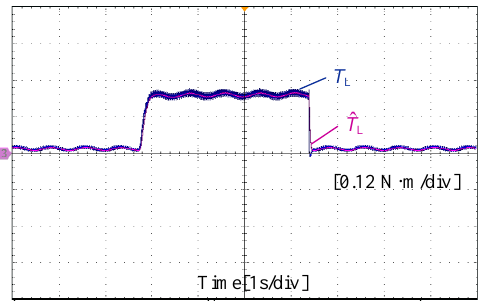
Figure 12. Evaluation of the second-order sliding mode load torque observer.